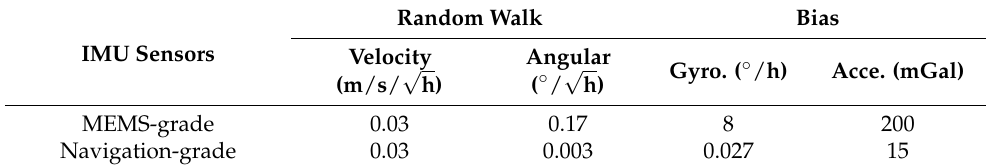
Table 1. Performance parameters of the IMU sensors.